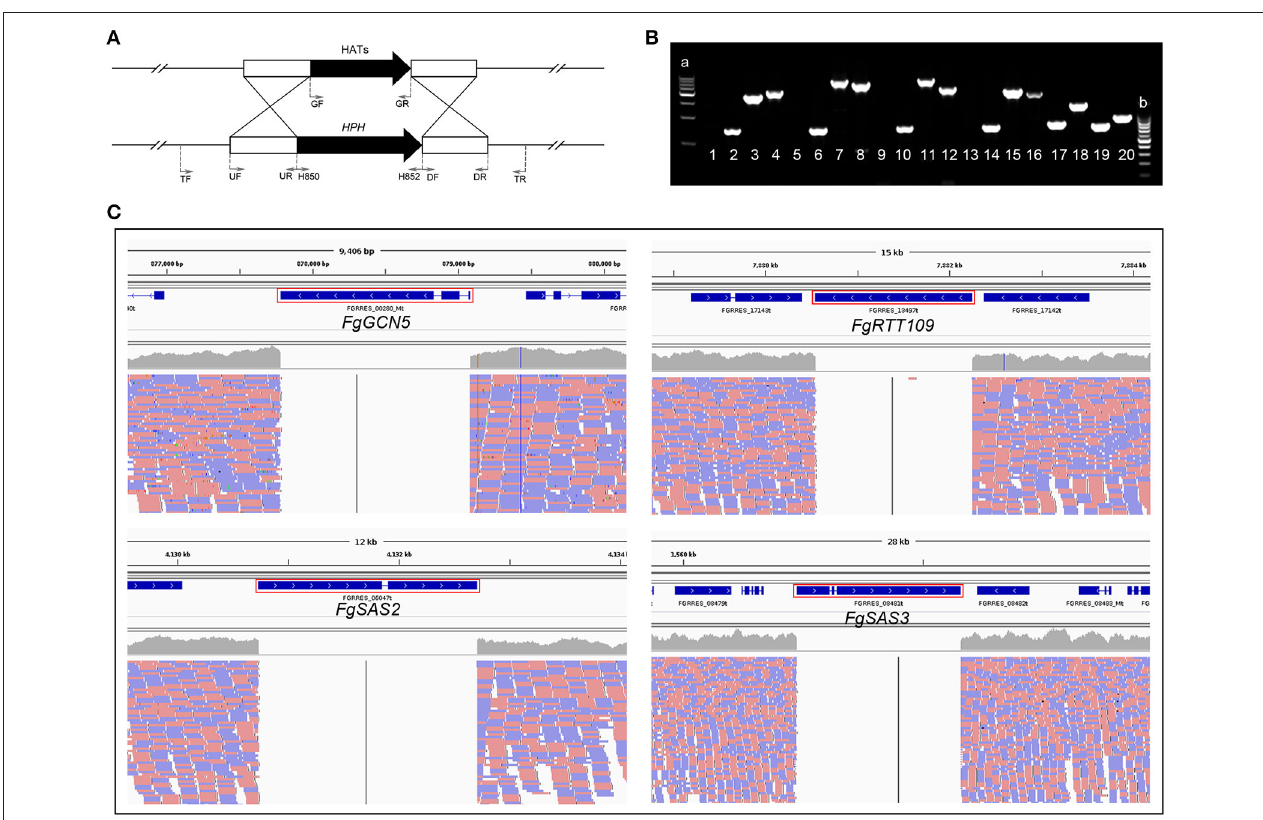
FIGURE 1 | Deletion of four HATs from the genome of wild-type strain PH-1, respectively. (A) Schematic representation gene disruption strategy. HAT gene and the hygromycin resistance cassette (HPH) are denoted by black and arrows. The annealing sites of primers UF/UR, DF/DR, TF/TR, GF/GR, H850/H852 are indicated by small black arrows. (B) Electropherogram of PCR products. a: 500 bp DNA ladder maker; b: 100 bp DNA ladder maker; Lane 1, 5, 9, 13: PCR products amplified with primers GF/GR using 1 FgRTT109 , 1 FgSAS2 , 1 FgSAS3 and 1 FgGCN5 as a template, respectively; Lane 2, 6, 10, 14: PCR products amplified with primers H850/H852 using 1 FgRTT109 , 1 FgSAS2 , 1 FgSAS3, and 1 FgGCN5 as a template, respectively. Lane 3, 7, 11, 15: PCR products amplified with primers TF/H852 using 1 FgRTT109 , 1 FgSAS2 , 1 FgSAS3, and 1 FgGCN5 as a template, respectively. Lane 4, 8, 12, 16: PCR products amplified with primers H850/TR using 1 FgRTT109 , 1 FgSAS2 , 1 FgSAS3, and 1 FgGCN5 as a template, respectively. Lanes 17-20: PCR products amplified with primers GF/GR using FgRTT109c, FgSAS2c, FgSAS3c, and PH-1 as a template, respectively. (C) Genome re-sequencing of four mutants. The location of FgGCN5 , FgRTT109 , FgSAS2 , FgSAS3, and on chromosomes was marked in red